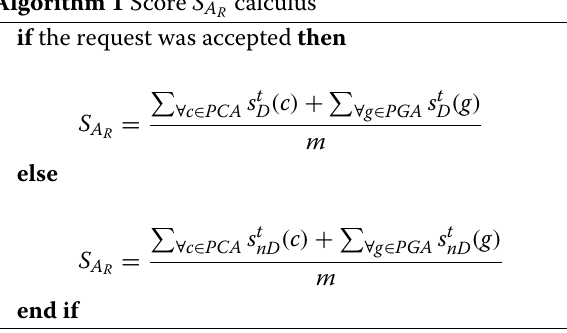
33 groups of criteria of size two, and 36 groups of size three. Groups of size three are actually the possible alter- natives of abstract rules that Kapuer can propose to the user. Groups of size two helps to better evaluate interac- tions between criteria. At the same time, Kapuer asks the user to make a decision (Accept or Deny the request) and records it (see Fig. 6). This interaction is displayed only if Kapuer has no authorization rule to matches the request (corresponds to the step 3 in Fig. 1). This decision allows Kagop to update f t and g t for every criteria, meta-criteria, and groups.